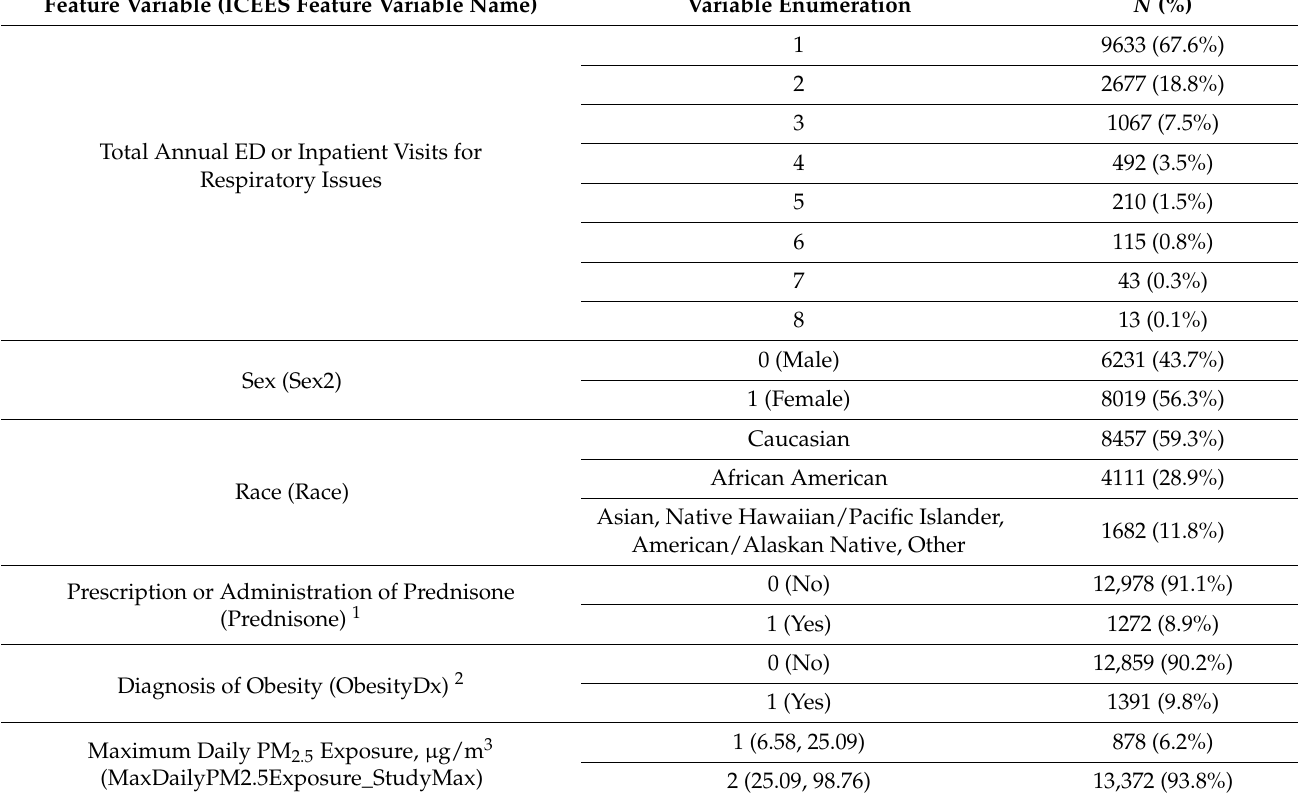
Table 1. Summary statistics for final ICEES multivariate dataset used for model development.